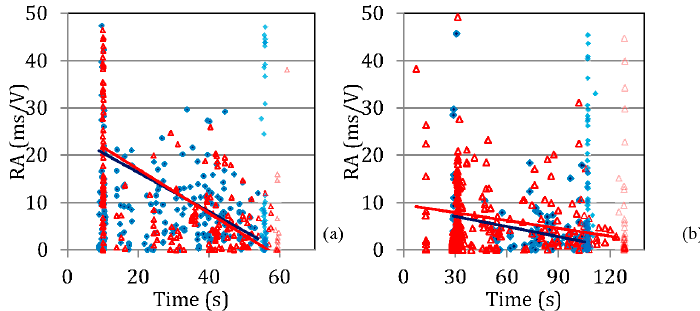
Figure 8. RA values for two specimens of marble type ( a ) MA and ( b ) MB. Table 1. Results of the bending tests for two types of marble.